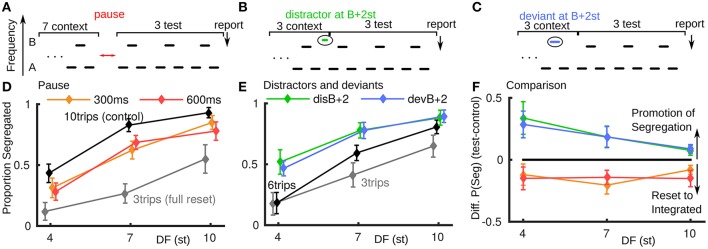
Promotion of segregation by distractor and deviant tones, behavioral data (normal hearing subjects, N = 8). (A) Paradigm for pause of 300 or 600 ms after 7 context triplets, followed by 3 test triplets, where subjects report percept of final triplet. (B) Paradigm for distractor falling in the normal gap between last of 3 context triplets and first of 3 test triplets. (C) Paradigm for deviant B tone in last of 3 context triplets. (D) Brief pauses in stimulus presentation result in a partial reset to integrated. The test conditions (red, orange) would align with the 10-triplet control (black) if the pause had no effect and align with the three-triplet control (gray) for a full reset to integrated. (E) Both a distractor tone in the gap between triplets or a deviant tone within a triplet can promote segregation. Proportion segregation increased for all test conditions (green, blue) relative to the control condition black. (F) Direct comparison between stimulus pauses and distractor or deviant tones shows an opposite effect. The difference in proportion segregated between test and control conditions in (A) and (B) is plotted; when the difference is positive there is promotion of segregation, when negative a reset to integrated.